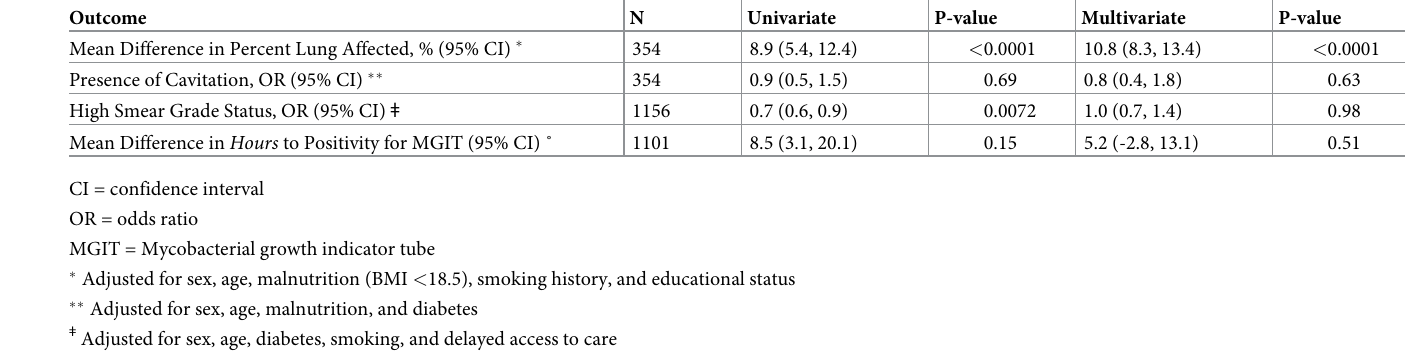
Table 2. Univariable & multivariable linear regression analyses on relationship between any alcohol use and various tuberculosis outcomes, reference group is non- drinkers. Outcome N